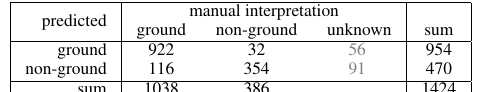
Table 1. Confusion matrix for the 2007 DTM. The